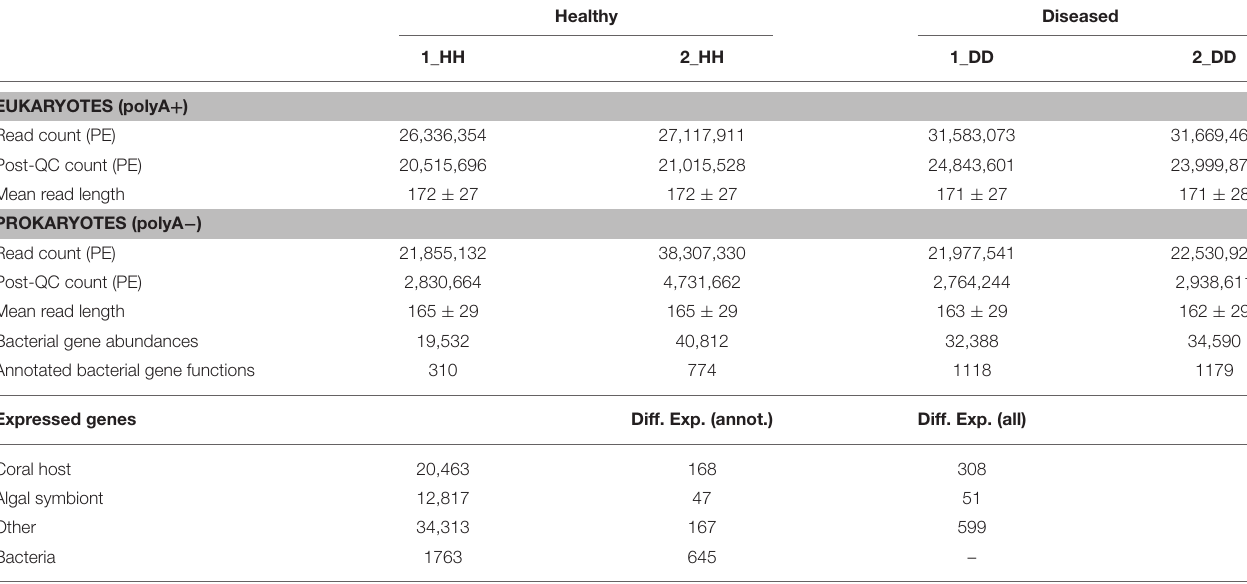
TABLE 1 | Sequence overview, statistics, and gene expression in healthy and WPD affected samples of Orbicella faveolata